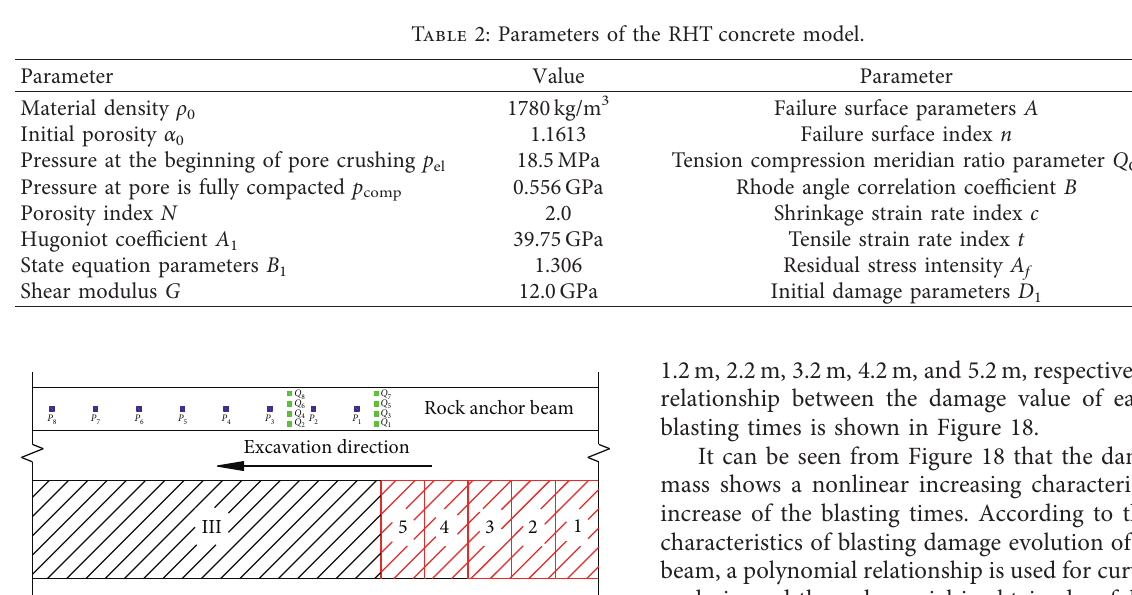
Figure 7: Schematic diagram of the monitoring point design of rock anchor beam